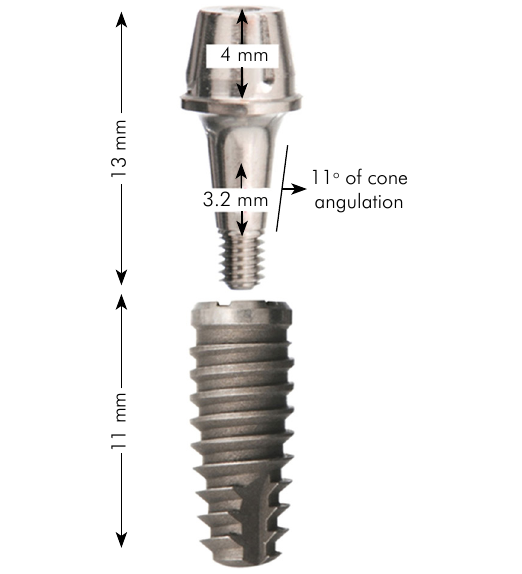
Figure 1. Image showing the characteristics of the implant and abutment used in this